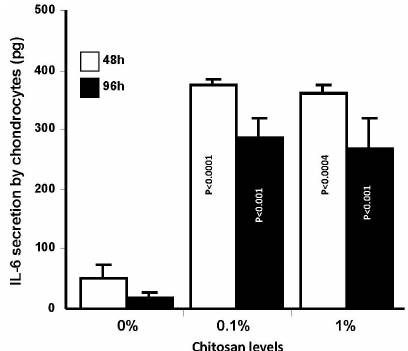
Figure 10. Effect of chitosan ‐ coated collagen membranes on chondrocyte IL ‐ 6 secretion. Cells were cultured on membranes for various time periods. The supernatants were collected to quantitate IL ‐ 6 levels by sandwich enzyme ‐ linked immunosorbent assay. Values are means ± SD ( n = 4). The difference was considered statistically significant at p < 0.05.